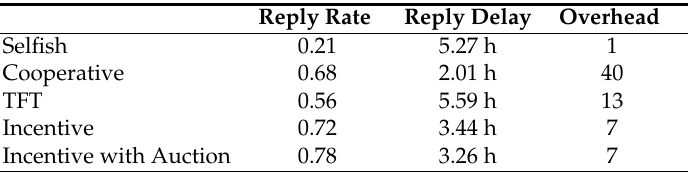
Table 2. Overall performance comparison based on the Haggle trace.